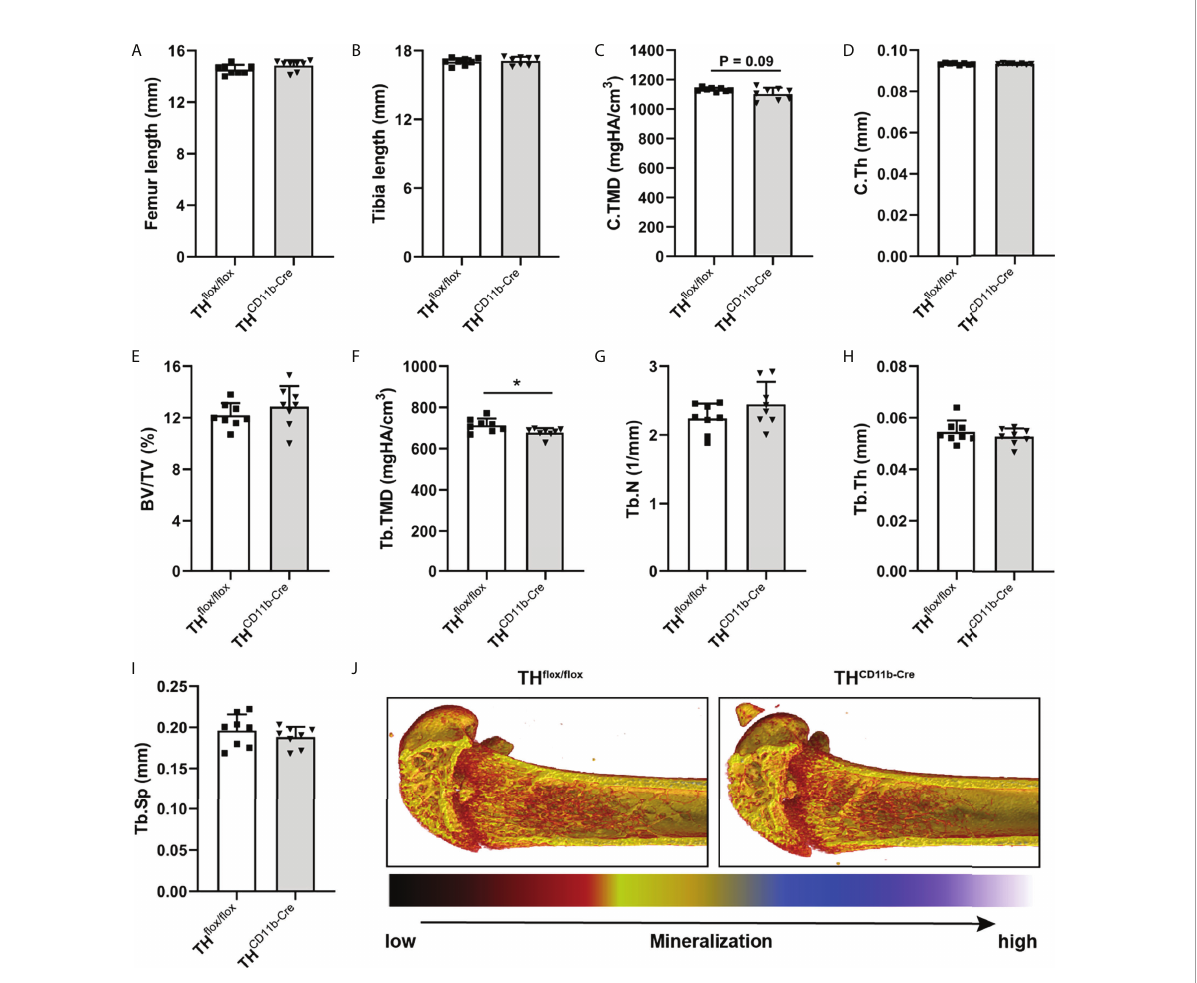
FIGURE 1 Bone phenotype of eight-week-old TH CD11b-Cre mice. (A) Femur and (B) tibia length of eight-week-old TH fl ox/ fl ox and TH CD11b-Cre mice. (C) Cortical tissue mineral density (C.TMD), (D) cortical thickness (C.Th), (E) bone volume to tissue volume ratio (BV/TV), (F) trabecular tissue mineral density (Tb.TMD), (G) trabecular number (Tb.N), (H) trabecular thickness (Tb.Th), (I) trabecular separation (Tb.Sp) and (J) representative µCT images of femora of eight-week-old TH fl ox/ fl ox and TH CD11b-Cre mice. n = 8; *P <